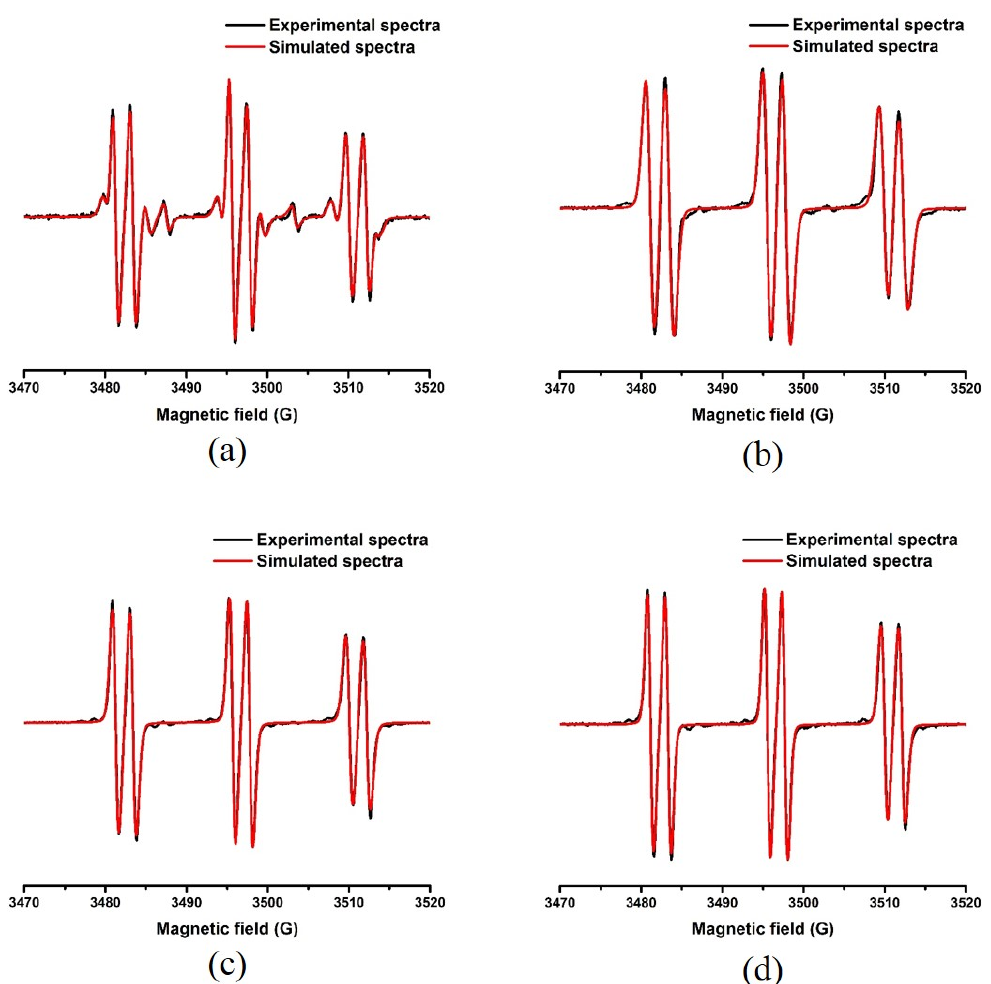
Figure 8. ESR-ST spectra of the radical adducts obtained in the presence of ( a ) BPC1; ( b ) BPC/EDB; ( c ) BPC1/Iod; ( d ) BPC1/EDB/Iod upon LED@365 nm irradiation in tert -butylbenzene.